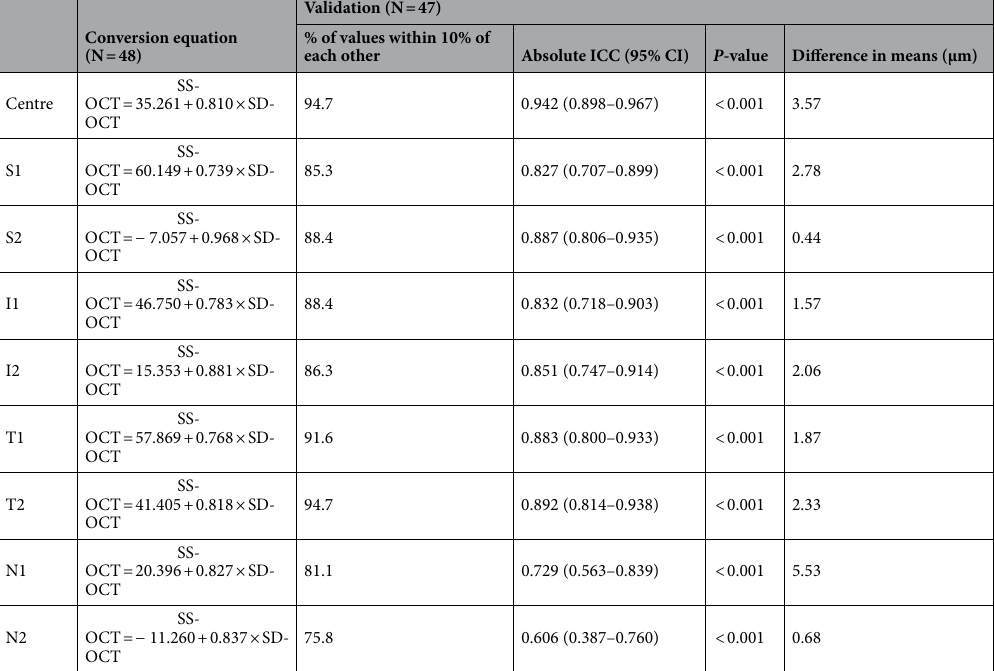
Table 4. Conversion equations and validation data. SS-OCT, swept-source optical coherence tomography; SD-OCT, spectral-domain optical coherence tomography; ICC, intra-class correlation coefficient of the two devices; Centre, central foveal; S1, inner superior; S2, outer superior; I1, inner inferior; I2, outer inferior; T1, inner temporal; T2, outer temporal; N1, inner nasal; N2, outer nasal. 95 participants were included in the conversion equation analysis after exclusion of outliers (N = 19). Conversion equations were derived based on random half sample of participants (N = 48) and validation were based on the second half sample (N =